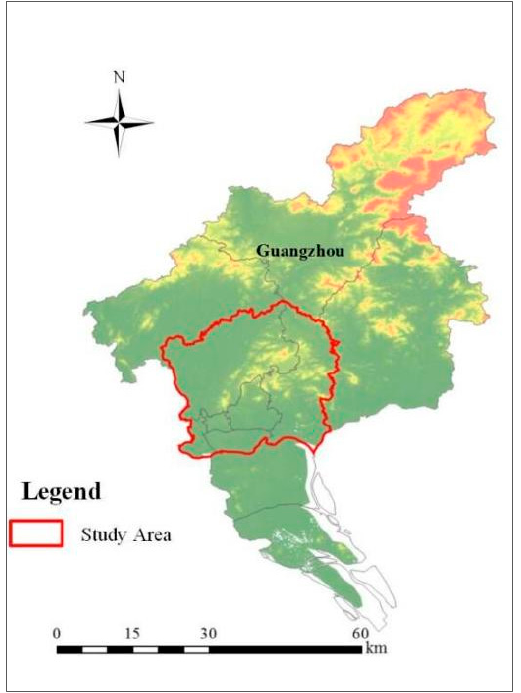
maps from 1980 to 2015 (Figure 3). Figure 2. Map of study area. (Source: drawn by the authors). Figure 2. Map of study area. (Source: drawn by the authors).